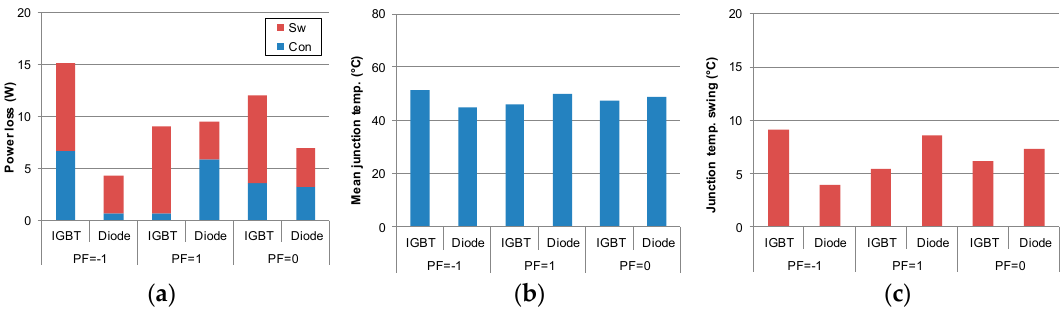
Figure 5. Impacts of various power factors (PFs) on power module. ( a ) Loss dissipation. ( b ) Mean junction temperature. ( c ) Junction temperature swing.